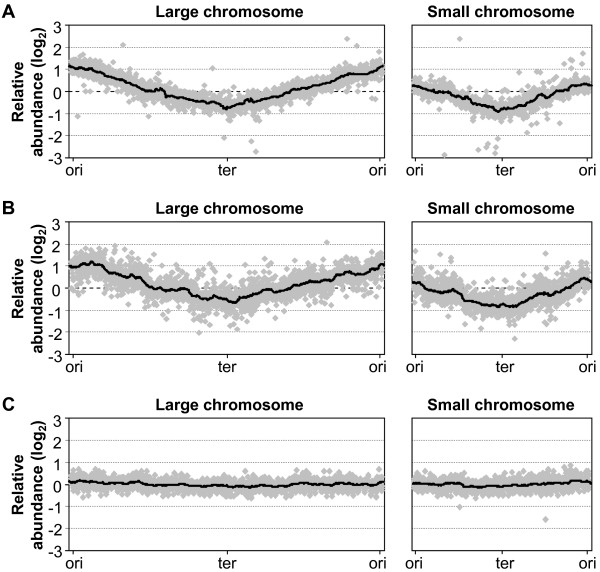
Replication pattern for exponentially growing V. parahaemolyticus determined by gDNA/gDNA microarrays. Genomic DNA (gDNA) from V. parahaemolyticus in exponential phase (OD600 ~ 0.5) grown in LB with 3% NaCl at 37°C (A) or 20°C (B) or in M9 with 3% NaCl supplemented with 0.4% glucose (C) was compared against gDNA from non-replicating cells on microarrays spotted with DNA from all ORFs. Large and small chromosomes are linearised from the origins over the termini and back to the origins. Grey diamonds represent individual data points and black trend-lines show a sliding average for 50 data points. Scales on the x-axes are an approximate illustration of the respective lengths of the large and small chromosome.